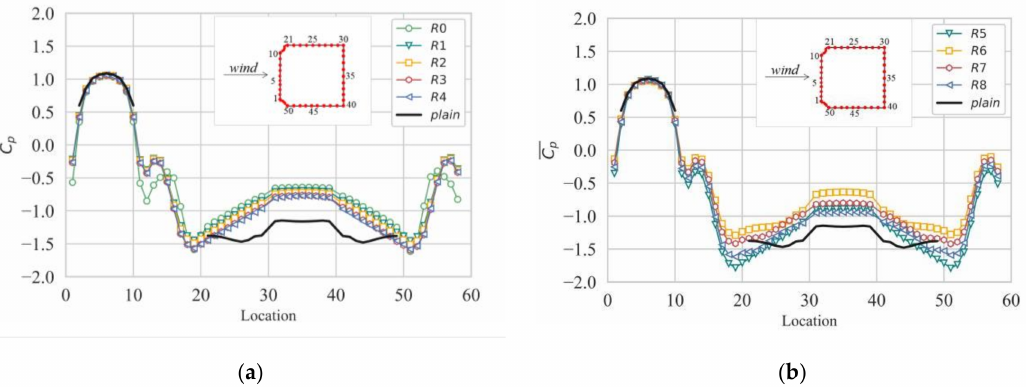
Figure 6. Mean pressure coefficients around the cylinder for the nine rotating cases and the plain cylinder: ( a ) V t / f s < 1; ( b ) V t / f s ≥